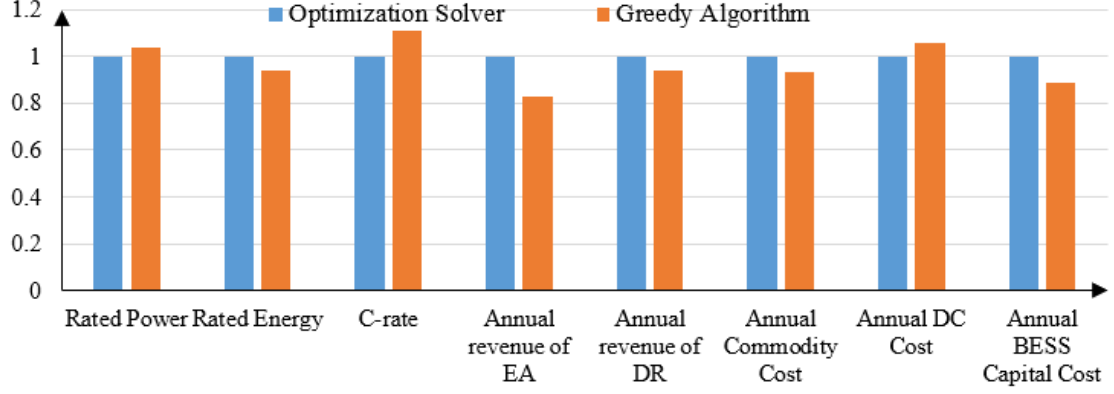
Figure 6. Comparison between the normalized results of the greedy algorithm and optimization solver.